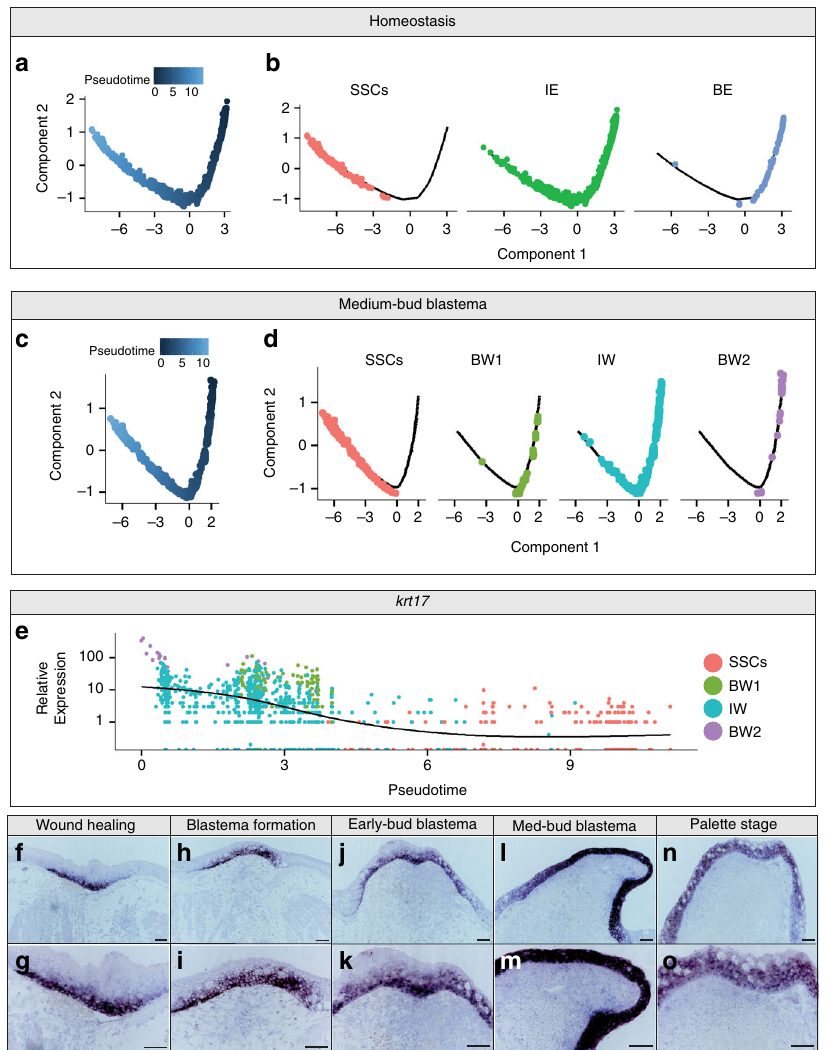
Fig. 3 The epidermis follows an outward differentiating trajectory. a – d Pseudotime analysis of epidermis populations during homeostasis ( a , b ) and in the medium-bud blastema ( c , d ), shown split by overall pseudotime plots ( a , c ) and colored by Seurat population determined in Fig. 1 ( b , d ). Abbreviations used are small secretory cells (SSCs), intermediate epidermis (IE), basal epidermis (BE), basal wound epidermis #1 (BW1), intermediate wound epidermis (IW), and basal wound epidermis #2 (BW2). e Expression plot of krt17 in epidermal cells captured at the medium-bud blastema stage over pseudotime, colored using Seurat populations as in d . f – o Representative RNA in situ hybridization probing for krt17 across a time course of limb regeneration. Magni fi cation ×10 in f , h , j , l , n , ×20 in g , i , k , m , o . All scale bars are 100 μ m. n = 4 animals per time